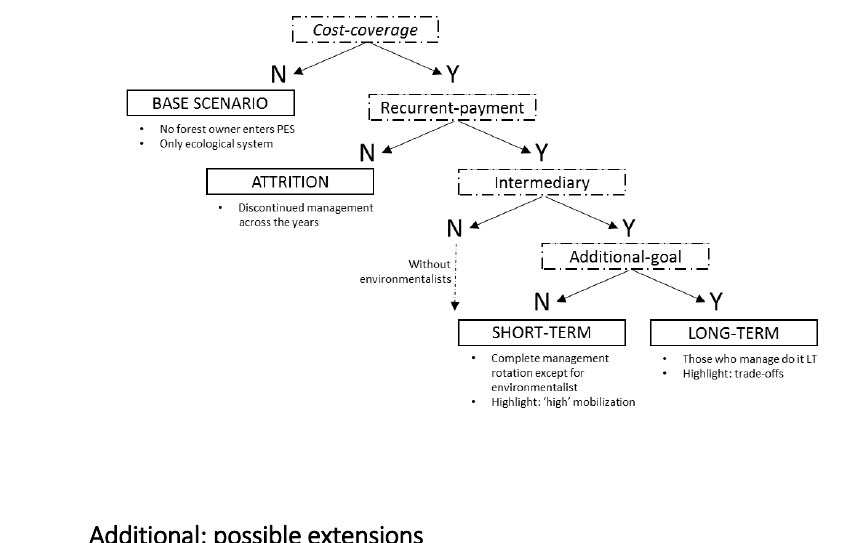
Figure 2. Type of policy design and behavioral responses: opted-for